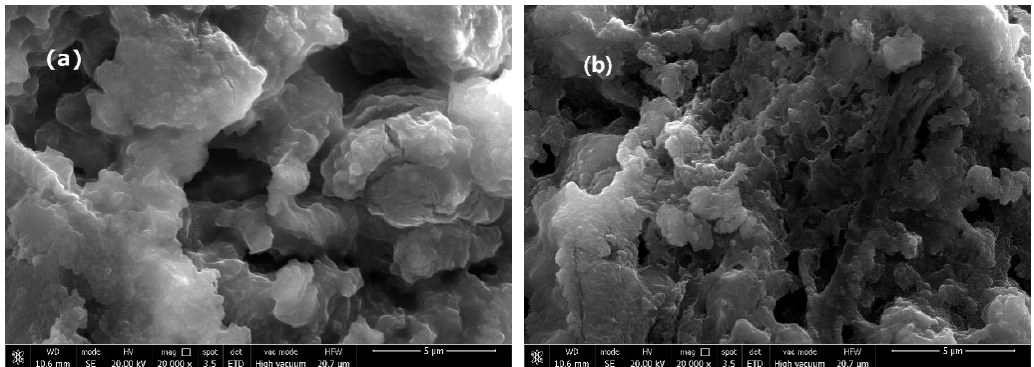
Figure 9. The SEM (scanning electron microscopy) images of the Ln@AC nanocomposite ( a ) before and ( b ) after adsorption of Zn(II).